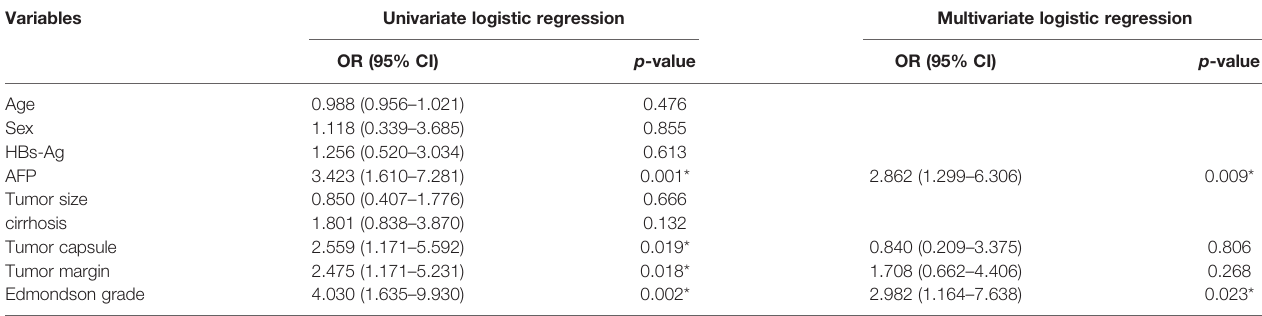
TABLE 2 | Univariate and multivariate logistic regression analysis of the preoperative clinical and radiological features of training group. Variables